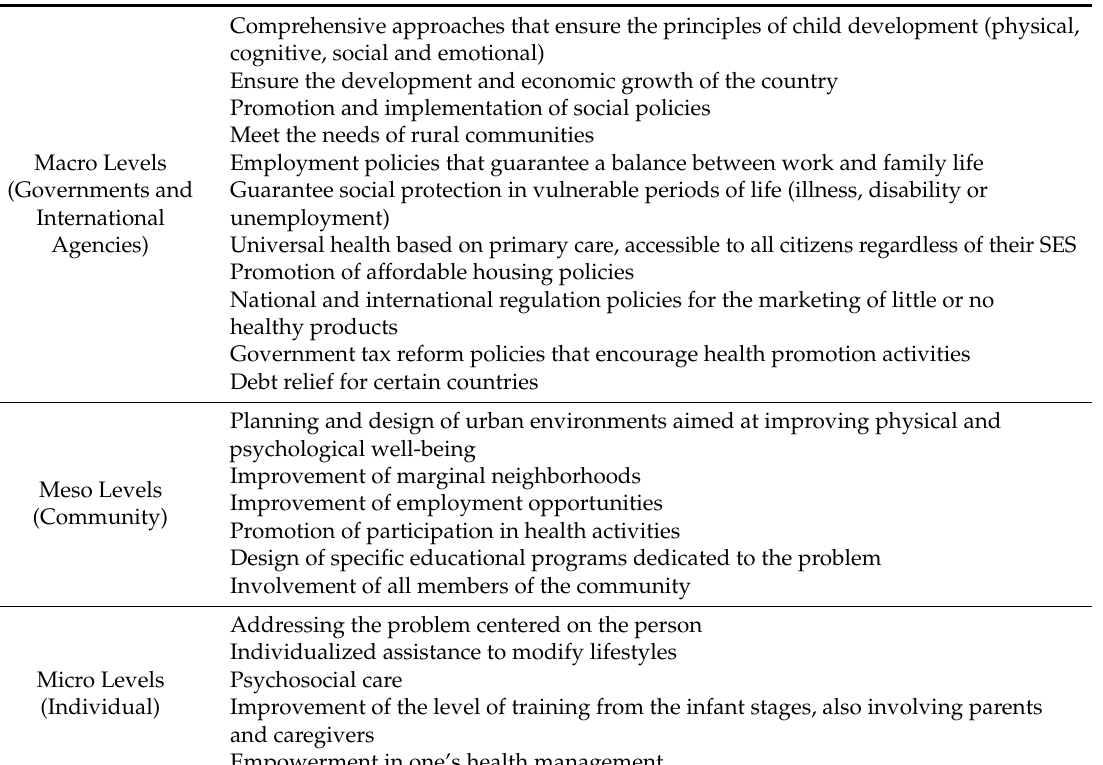
Table 7. Suggestion for improvement at the macro, meso and micro action